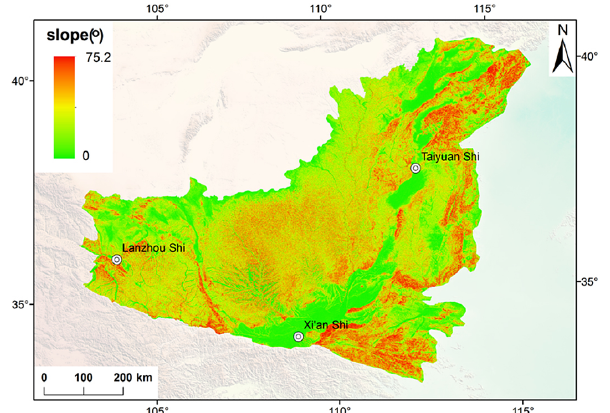
Figure 3. Slope distribution status in the Loess Plateau of China.